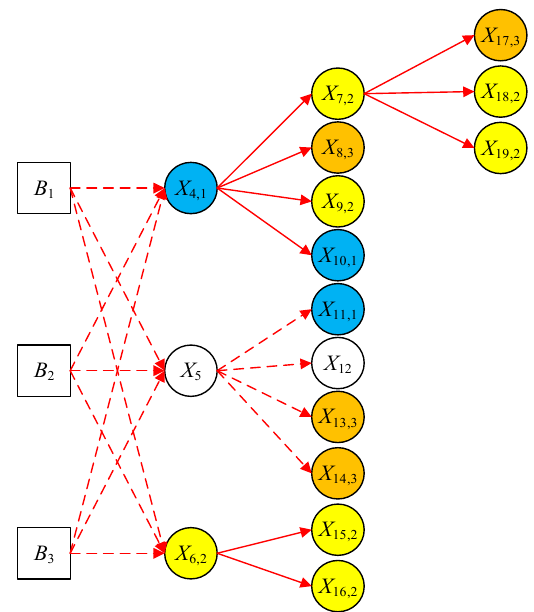
Figure 11. Evaluation model of Fushun-Yongchuan in E 5.